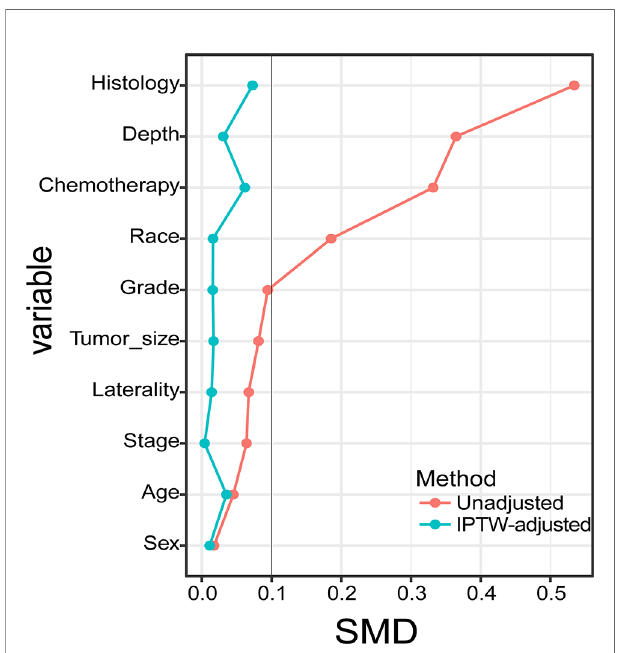
FIGURE 3 | Standardized mean differences of different cohorts are presented in this